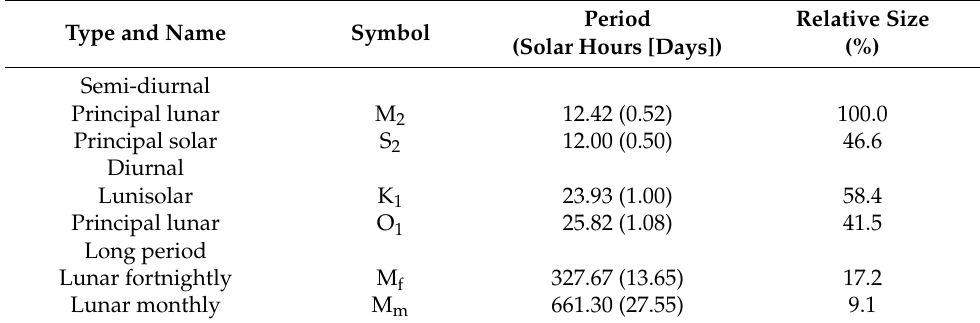
Table 1. Characteristics of principal tidal constituents.